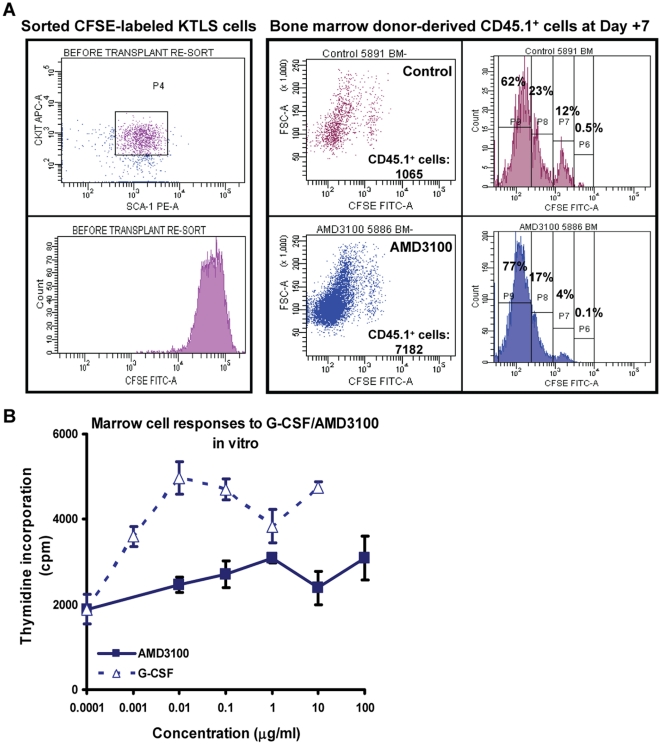
Post transplant administration of AMD3100 increase donor cell division.A: In vivo cell division measurement. CD45.1+ KTLS cells were labeled with CFSE and injected into lethally irradiated C57BL/6 CD45.2 Thy1.2 mice (7×103 KTLS cells/mouse). The 2 panels on the left showed the sorted CFSE-labeled KTLS cells prior to injection to recipient mice. The recipient mice were treated with AMD3100 at 5 mg/kg or PBS every other day beginning at day +2. The mice were sacrificed at day +7 and bone marrow cells measured for CFSE intensity (The 4 panels on the right. Top 2 panels: recipient mice treated with PBS control; Lower 2 panels: recipient mice treated with AMD3100). The CFSE intensity was gated on CD45.1+ donor derived cell population (n = 5 mice in each group). B: In vitro marrow cell proliferation responses to AMD3100 or G-CSF. Marrow cells (5×105/well) were cultured with various concentrations of AMD3100 or recombinant G-CSF, and [3H] thymidine incorporation was measured (three separate sets of experiments with triplicates in each experiment).